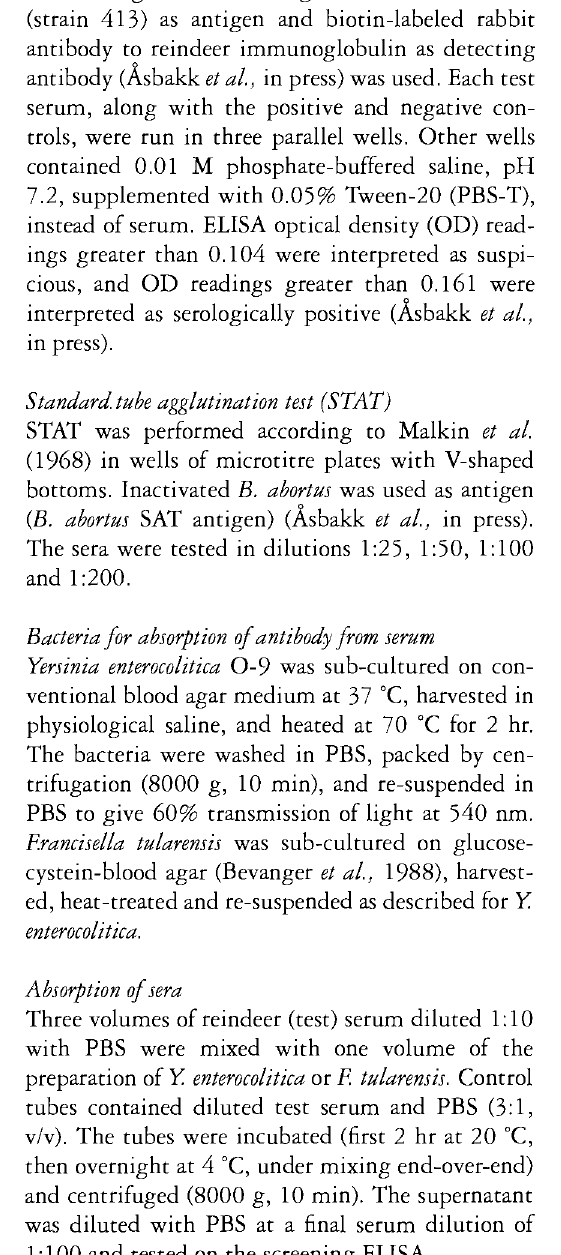
Table 2. Age and year of sampling of reindeer tested for Brucella